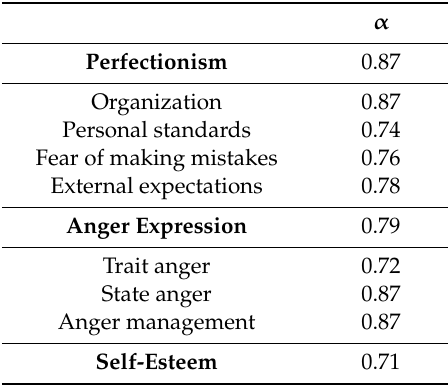
Table 1. Descriptive statistics of the